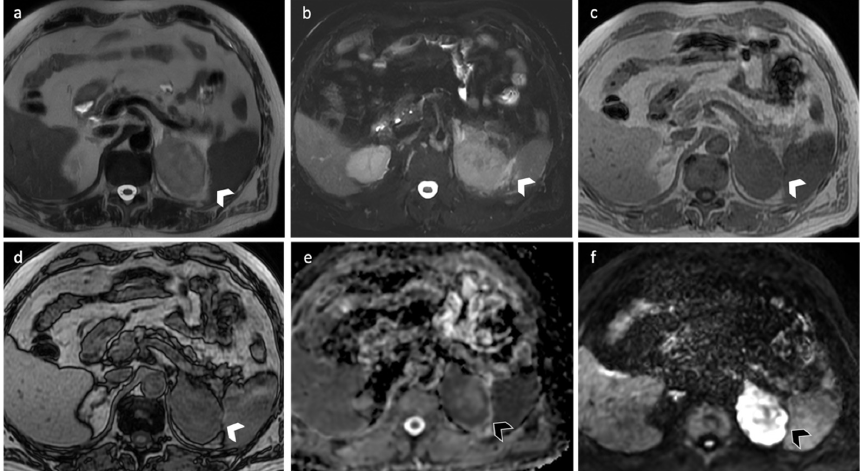
Figure 8. A 67-year-old man with lung cancer. MRI shows a 7 cm nodular lesion on the left adrenal gland characterized by intermediate signal intensity on axial T2-weighted images ( a ) and perile- sional edema ( b ). The lesion shows intermediate T1-intensity ( c ) with no signal loss in out-of-phase sequences ( d ), due to the absence of intralesional fat. DWI ( e ) and ADC map ( f ) demonstrated hy-